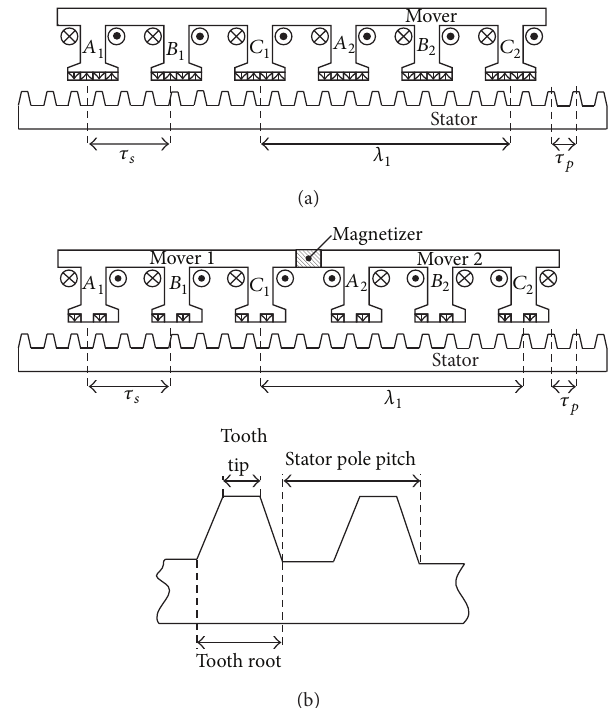
Figure 1: Comparison of topologies. (a) Existing LVH machine. (b) Proposed LFTPMV machine.